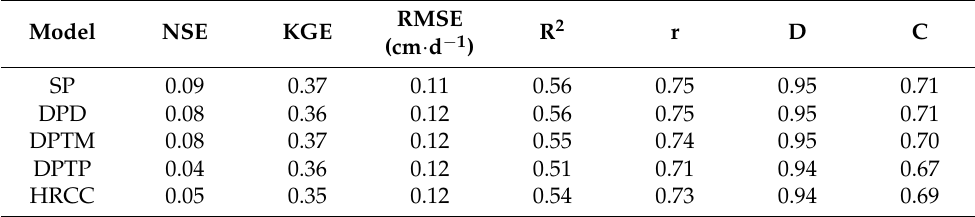
Table 8. Statistics of the model adjustments for the ETa measured in the Caatinga area. Model